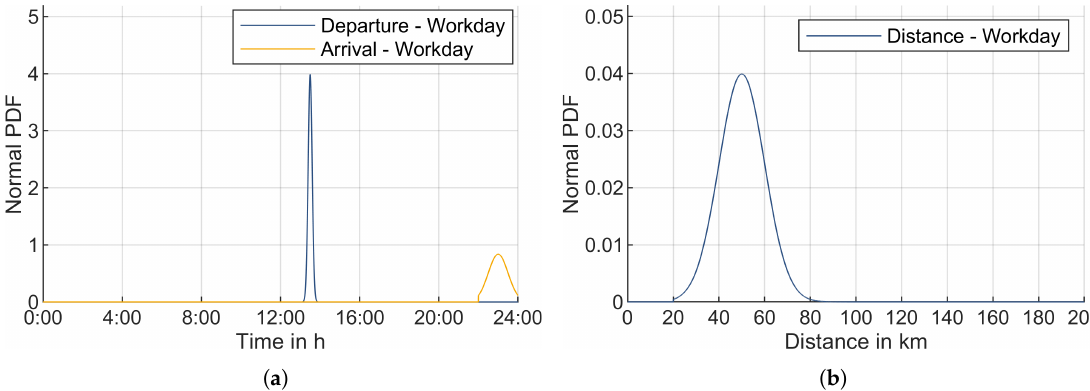
Figure A1. Probability distribution functions (PDFs) of the driving profiles for mobility profile Late Worker on a workday. ( a ) PDF of the normal distribution used to model the departure and arrival times at home on a workday (Monday–Friday) for mobility profile Late Worker ; ( b ) PDF of the normal distribution used to model the driving distance on a workday (Monday–Friday) for mobility profile Late Worker .